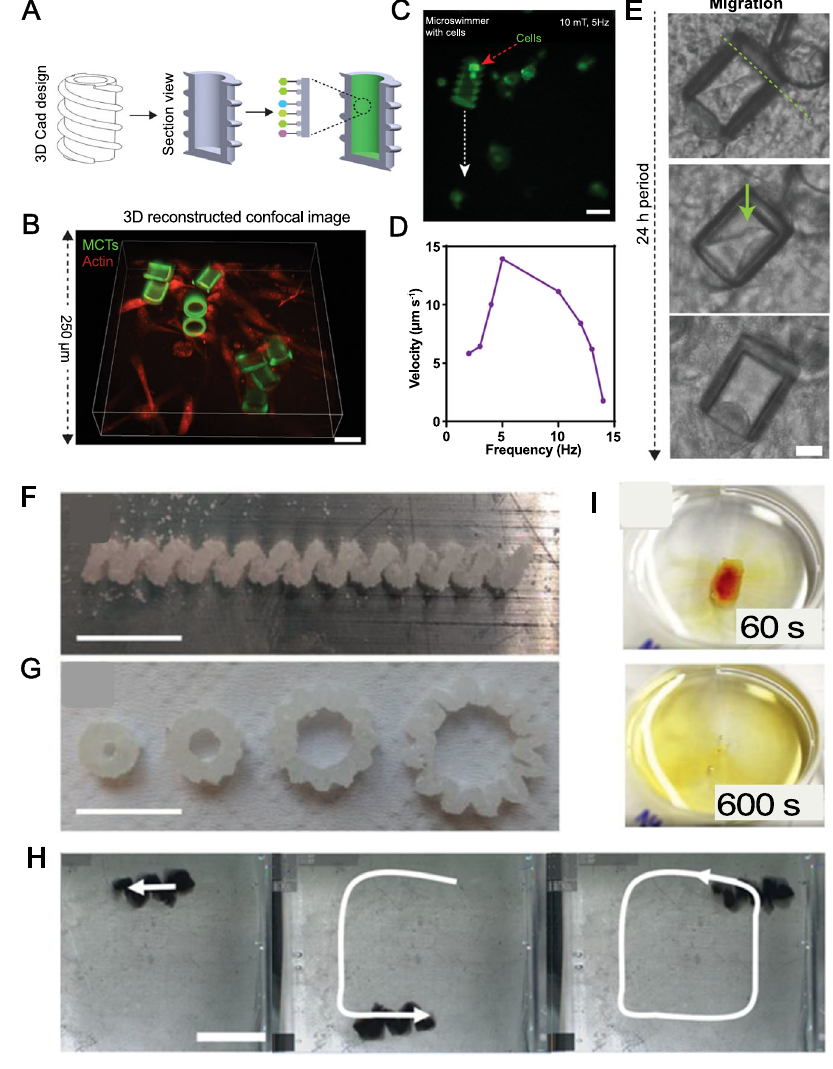
Fig. 6 | Cargo delivery and dissolvable microrobots. A – E Three-dimensional 3D-printed microrobot cell transporter (MCT) with the ability to deliver stem cells in vitro. A Computer-aided design (CAD) design was two-photo- polymerization (TPP) 3D-printed, and the inner surfaces of the structure were modi fi ed to increase stem cell bonding capability. B 3D confocal image of cell- loaded MCTs after 72h of being in Matrigel (red: actin; green: RUNX2, osteo- genic cell marker) (scale bar: 60 µ m). C Image of an MCT with encapsulated cells during rotational actuation (propulsion) and steering in vitro with a 10mT, 5Hz magnetic fi eld (scale bar: 50 µ m). D Graph of the average speed of MCTs with respect to different frequencies of a 10mT magnetic fi eld.